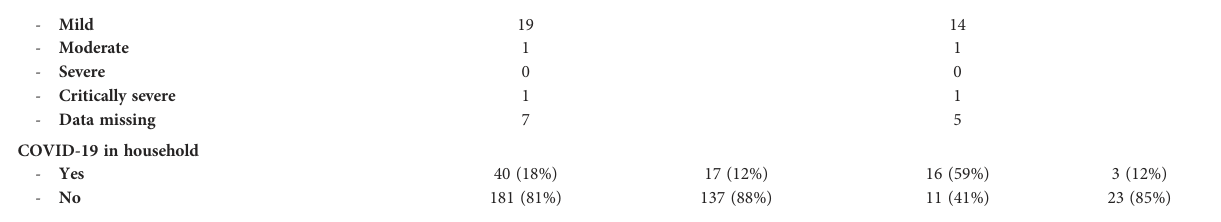
Supplementary Figure 2. We observed heterogeneity in the S- RBD- and N-speci fi c IgG prevalence: seroprevalence was higher for S-speci fi c IgG; 39% (82/212, 95% CI 32 – 45%) and RBD- speci fi c IgG; 38% (80/212, 95% CI 31 – 44%) compared to N- speci fi c IgG; 18% (38/212, 95% CI 13 – 24%) in the Luminex assay (Figure 1) (P < 0.001). In saliva, we similarly observed